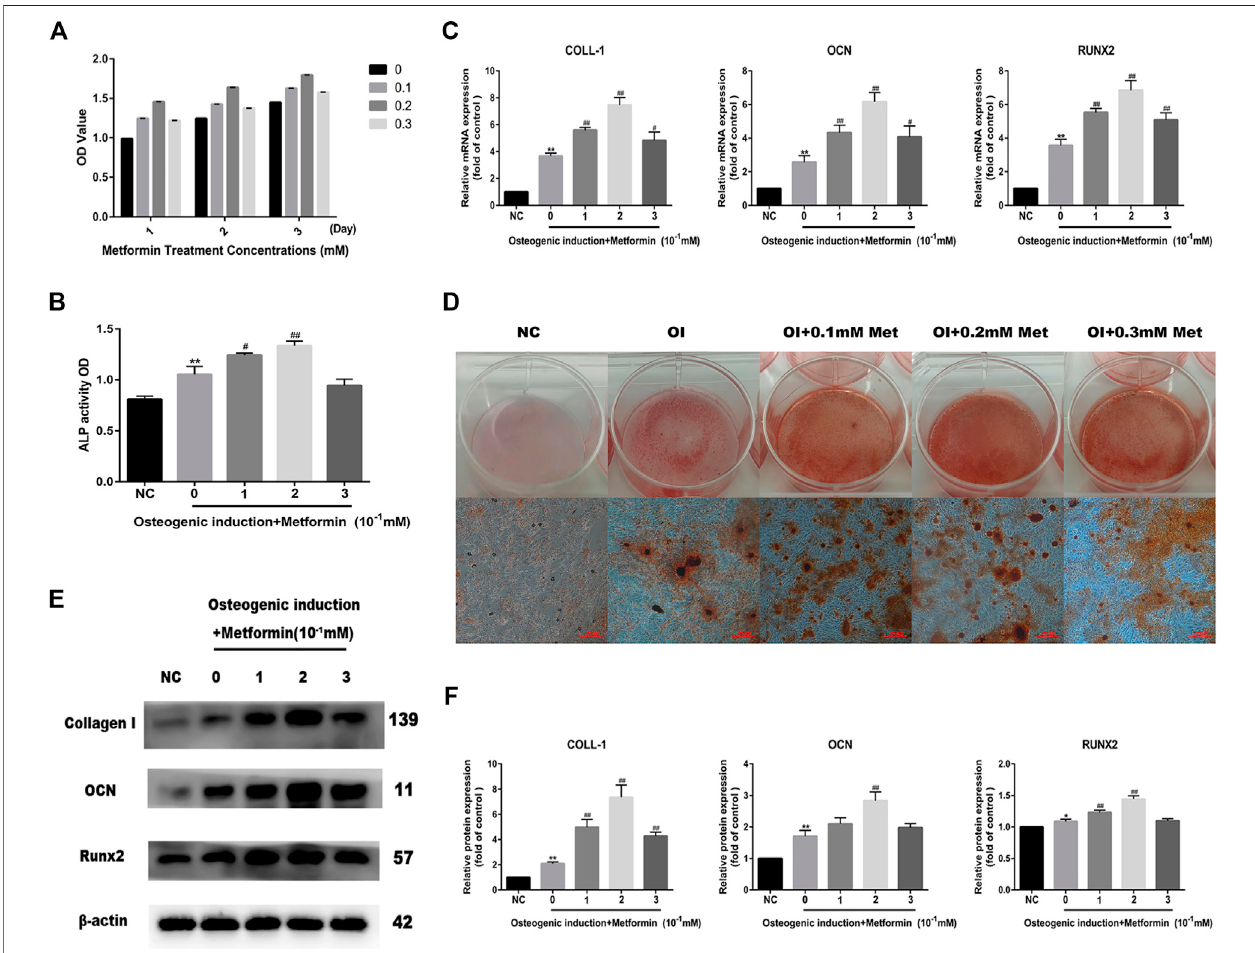
FIGURE 1 | Metformin promotes osteogenic differentiation of MC3T3-E1 cells. (A) Cell viability after treatment with different concentrations of metformin (0.1, 0.2 and0.3 mM). (B) ALPactivitywasdetectedtoexplicittheosteogeniceffectofmetformin. (C) ThemRNAlevelofCOLL-1,OCNandRunx2afterosteogenicinductionand treatmentwithmetformin. (D) ThemineralizationofosteoblastdemonstratedbyAlizarinredSstainingwasmostobviousaftertreatmentwith0.2 mMmetformin. (E) The protein level of Collagen I, OCN and Runx2 under different concentrations of metformin. (F) Relative protein expression level of the proteins in (E) compared with control group. Experiments were implemented in triplicate. Dataare means ± SD, * p < 0.05, ** p < 0.01 compared with control cells and # p < 0.05, ## p < 0.01 compared with osteogenic induction alone analyzed by using ANOVA.